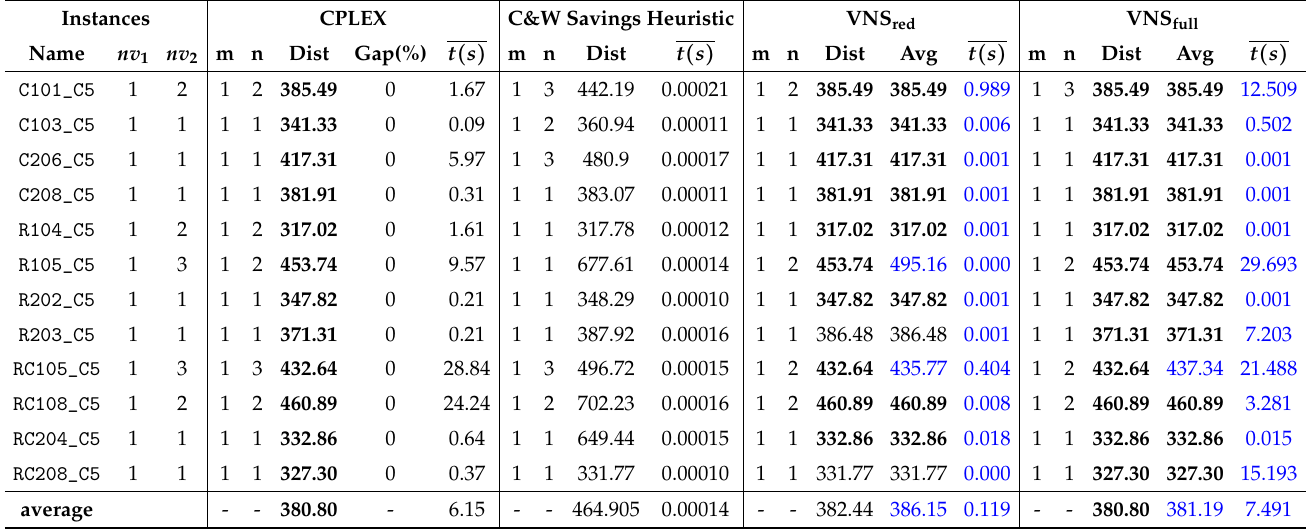
Table 5. Computational results for small-sized instances with 5 customers.